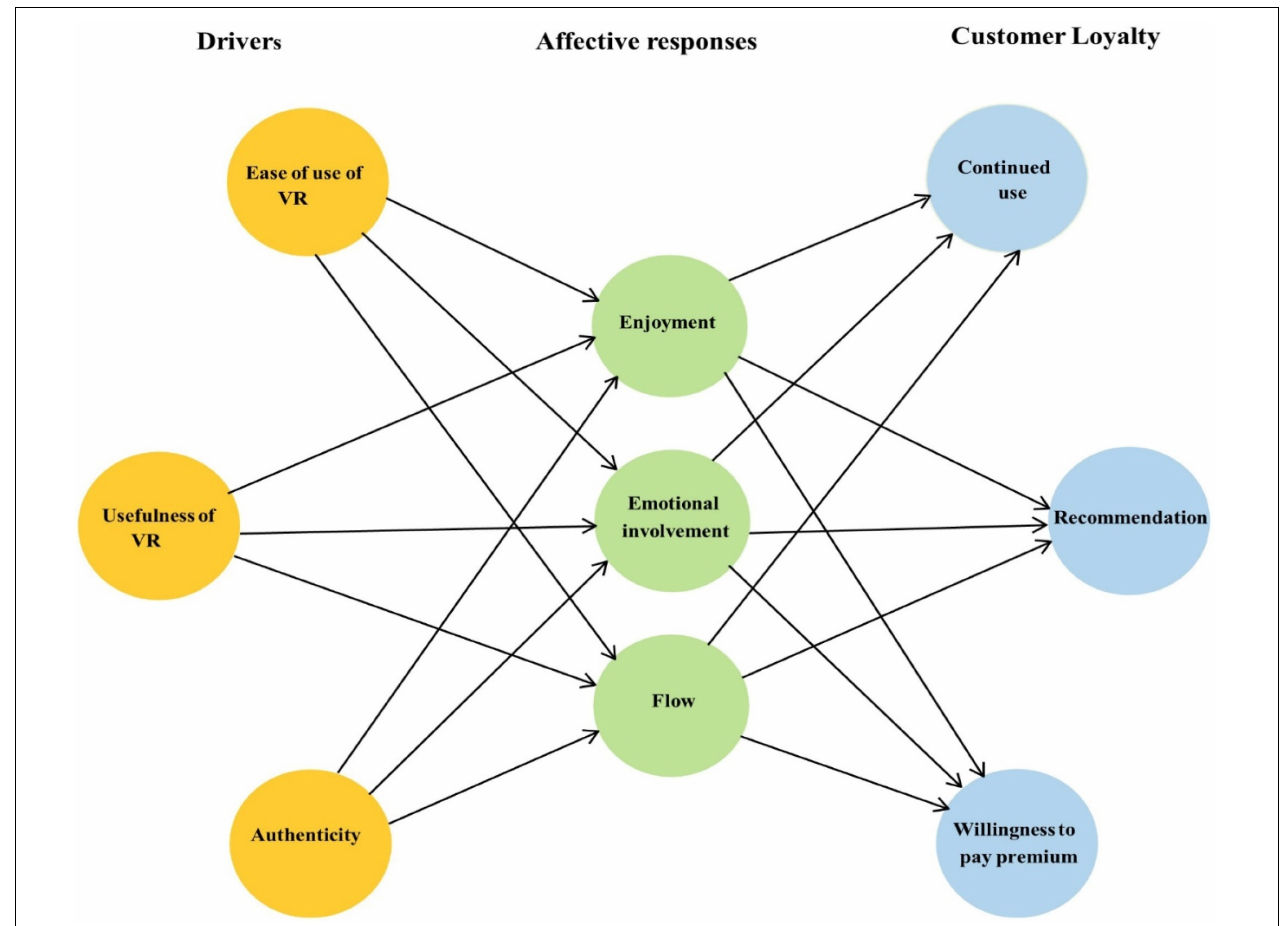
FIGURE 1 | Framework of the current